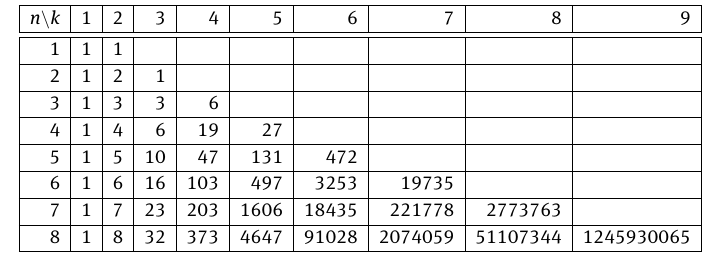
Table 14: Number of 0/1 -simplices in I n with 1 ≤ k ≤ n + 1 vertices for n ≤ 8 .